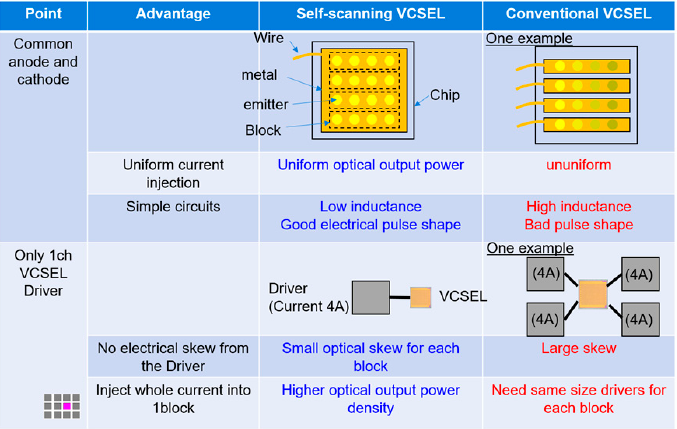
Figure 14. Advantages of the SS-VCSEL over conventional VCSELs.